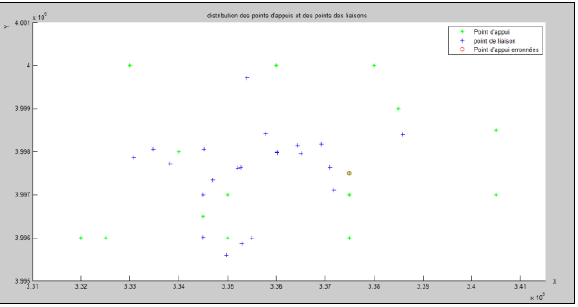
Figure 7. Distribution of ground control points (green), tie points (blue) in the first test and the erroneous GCP (red circle).